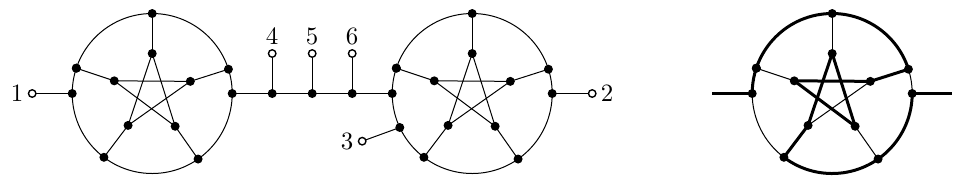
Figure 16: A tree-based network on the left and a Hamiltonian path through a blob derived from the Petersen graph on the